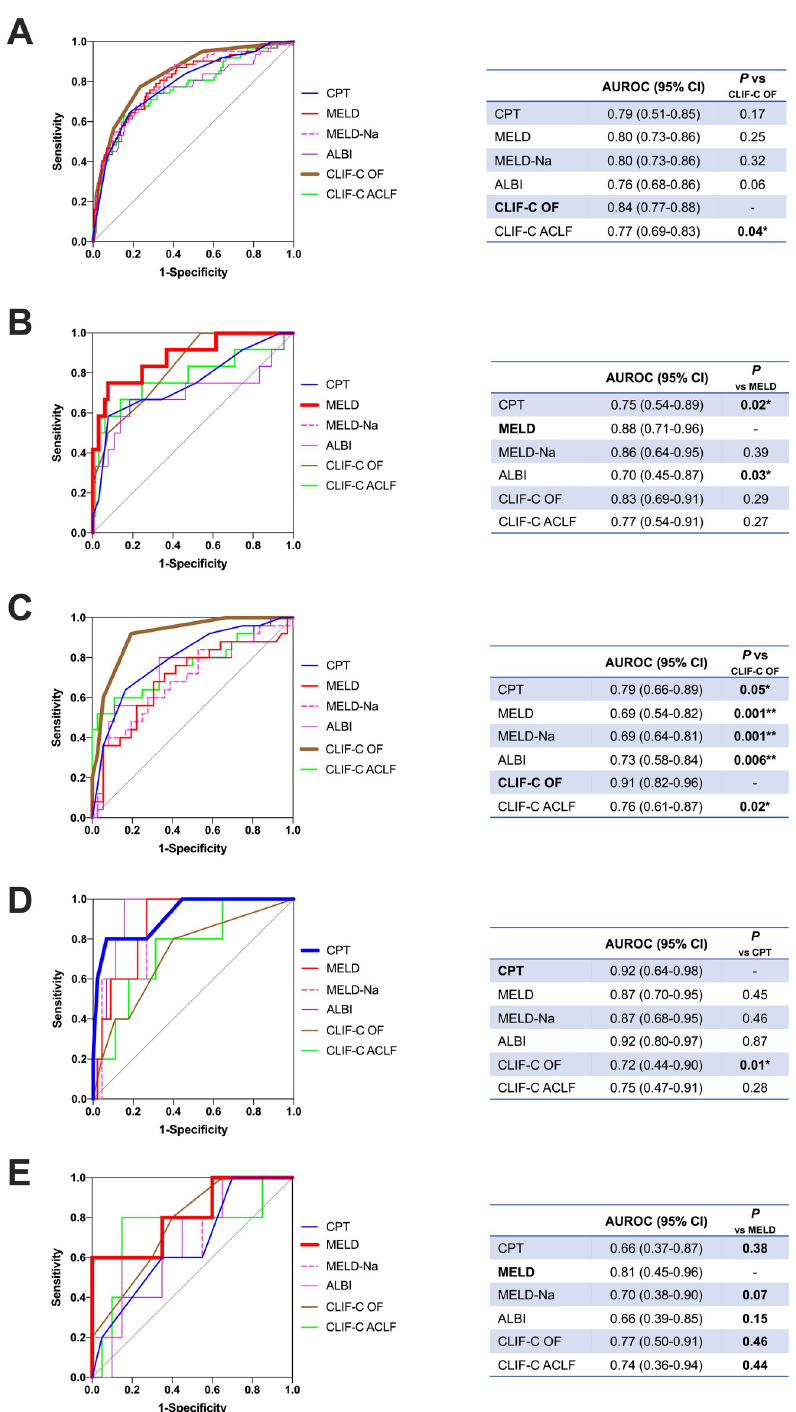
Fig 2. Comparison of various prognostic systems for 90-day transplant-free survival stratified by acute precipitants. ROC of different prognostic systems for all first indexed AD/ACLF (panel A) and those stratified by acute precipitants: Indeterminate (panel B), bacterial infection (panel C), GI bleeding (panel D), and alcoholism (panel E), are shown. AUROC are shown in tables with P -values compared by the DeLong method. � P < 0.05; �� P < 0.01.